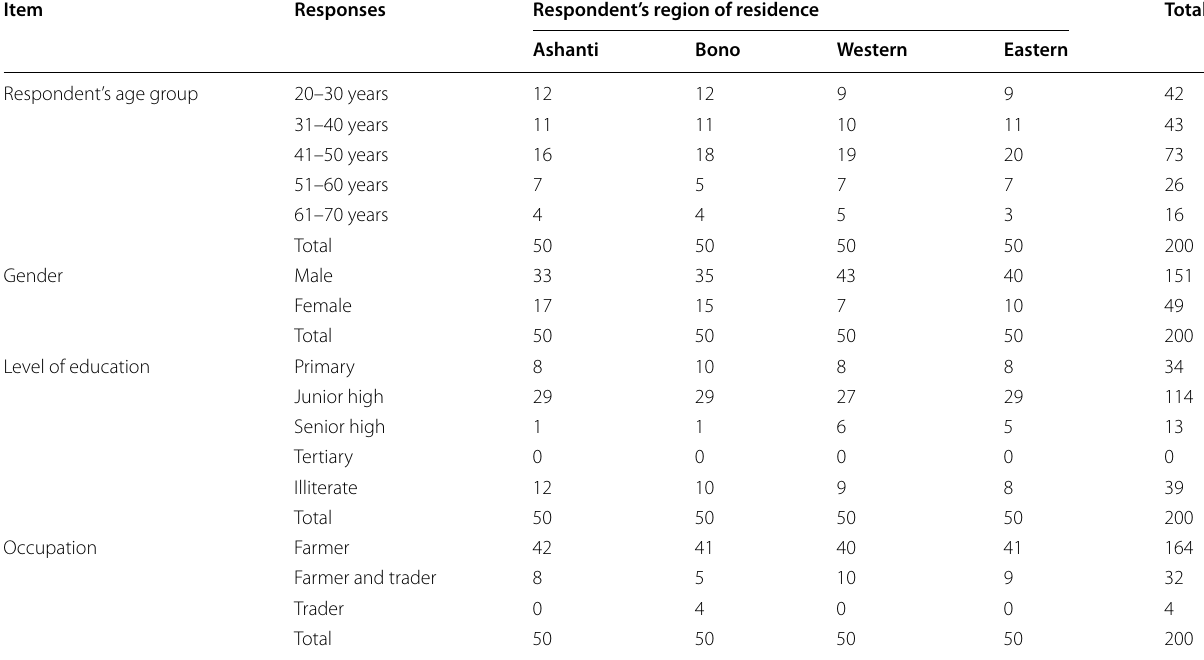
Table 1 Demographic characteristics of respondents (cross-tabulation) Item